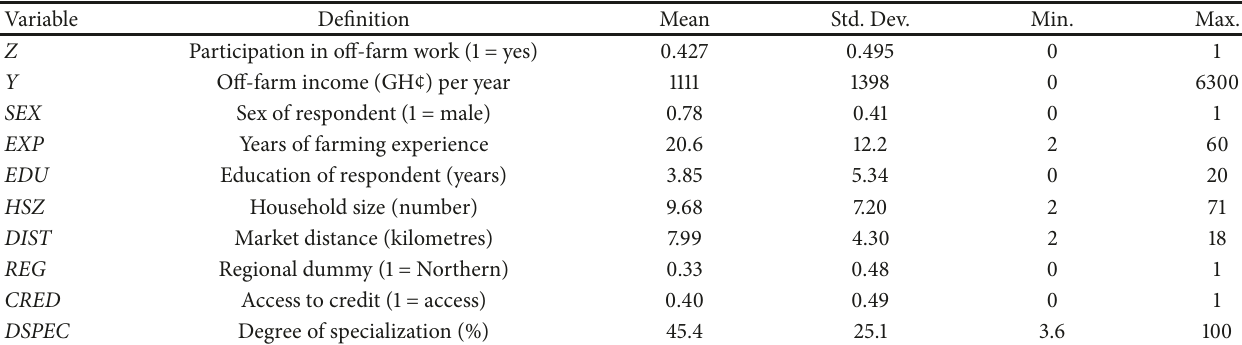
Table 1: Data description and summary statistics of the